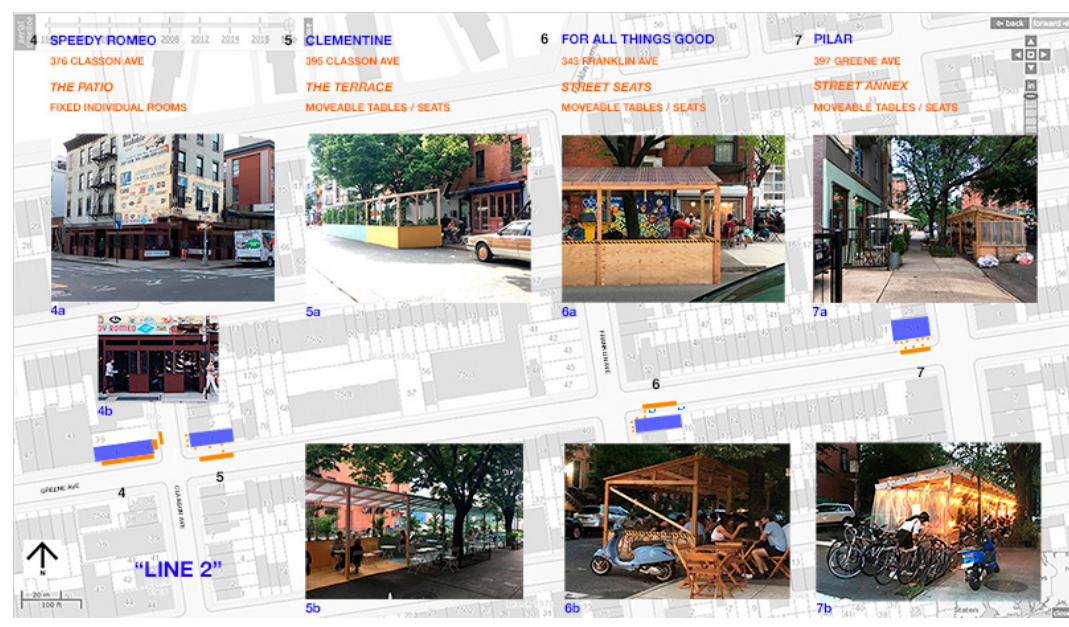
Figure 7. Eastern half of the Line: Speedy Romeo, Clementine, For All Things Good and Pilar present inventive street personalities: orange denotes street constructions, blue denotes indoor parcel (Source: author)